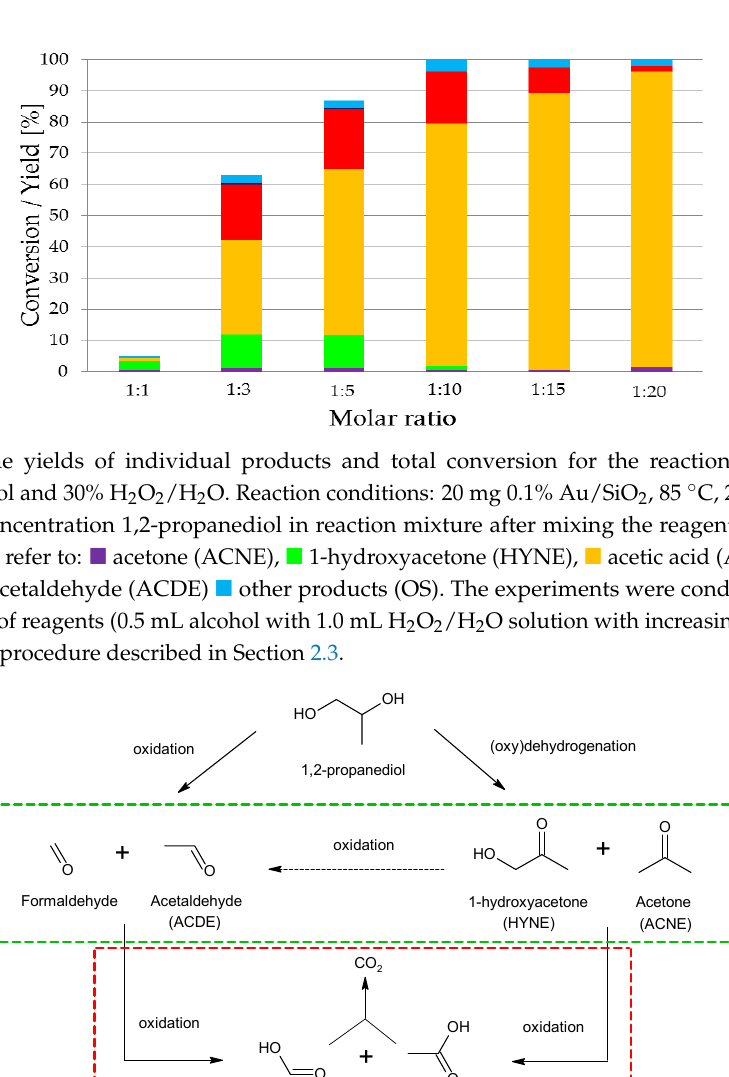
Scheme 1. Two route mechanism of oxidation or (oxy)dehydrogenation of 1,2-propanediol to acetic acid. Products in the green frame were mostly observed for the reaction mixture of 1,2-propanediol to H 2 O 2 in the proportion of 1:1, 1:3, or 1:5. Products in the red frame were mostly observed for the reaction mixture of 1,2-propanediol to H 2 O 2 in the proportion of 1:10, 1:15 or 1:20. The legend sitting under chemical formulas refers to the acronyms used in then text.